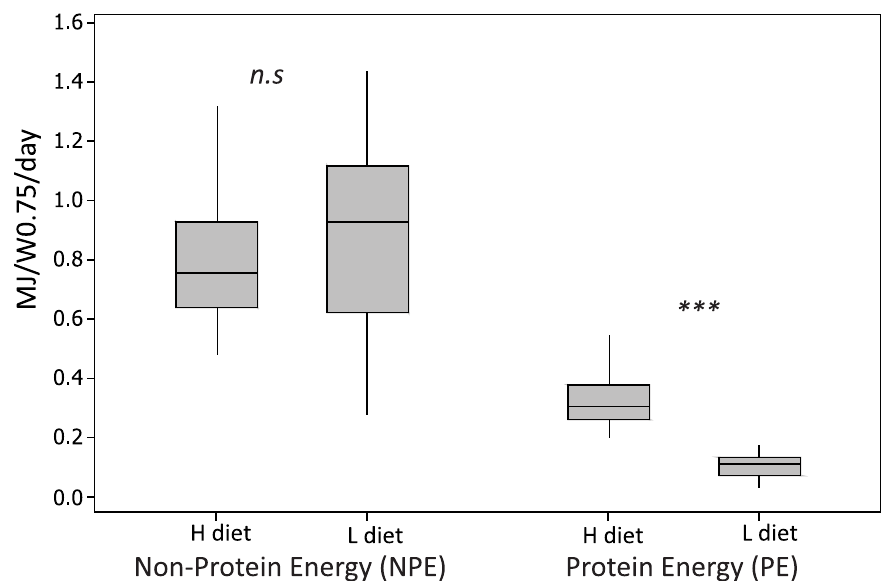
Fig 5. Interquartile box plot of the daily macronutrient intake by moose during the two no-choice phases of the experiment (the box represents the middle 50% of the data, whiskers represent the upper and lower 25% of the distribution). Daily protein energy (PE) intake per adult moose (MJ/W 0.75 /day) differed significantly between the two no-choice phases of the experiment (H diet: high protein, low carbohydrate; L diet: low protein, high carbohydrate), but the intake of non-protein (NPE) did not (statistical results in Table 5). Non-protein macronutrients include TNC1, lipids and dNDF (see text for